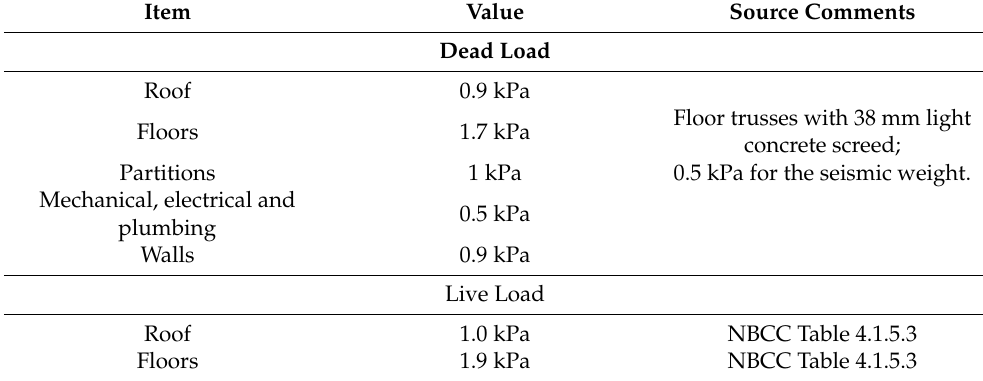
Table 4. Dead and live loads acting on the substructures’ floors and roofs used in the finite element model. Item